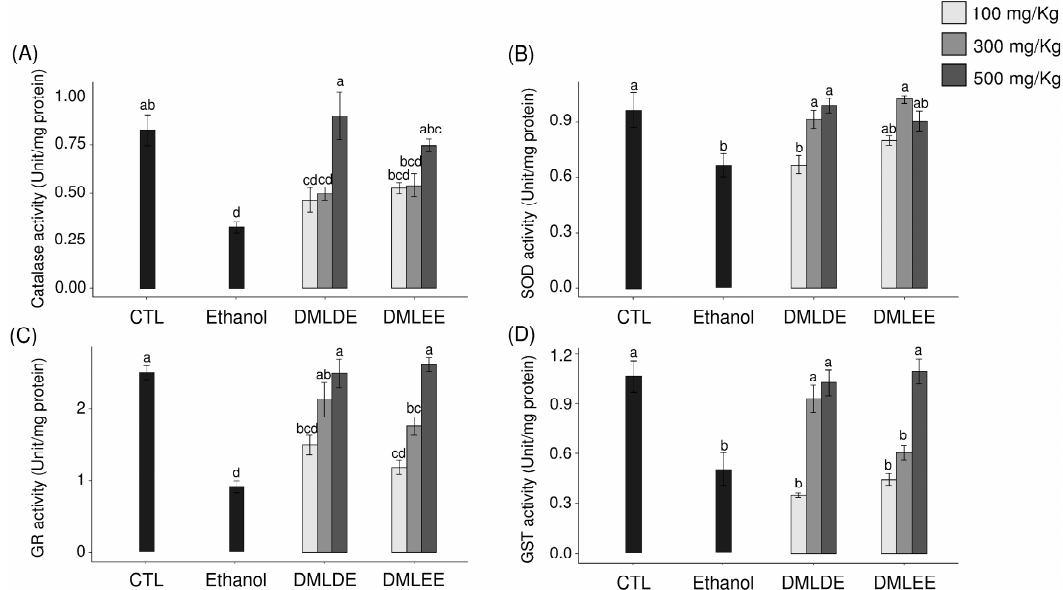
Figure 4. E ff ects of the Dendropanax morbifer leaf D.W and ethanol extracts on antioxidant enzyme activity in alcohol-fed rat. ( A ) Catalase activity, ( B ) SOD activity, ( C ) GR activity and ( D ) GST activity. The data are expressed as the mean ± SD ( n = 6), and di ff erent letters indicate (a > b > c > d) a significant di ff erence at p < 0.05, as determined by a Duncan’s multiple range test.